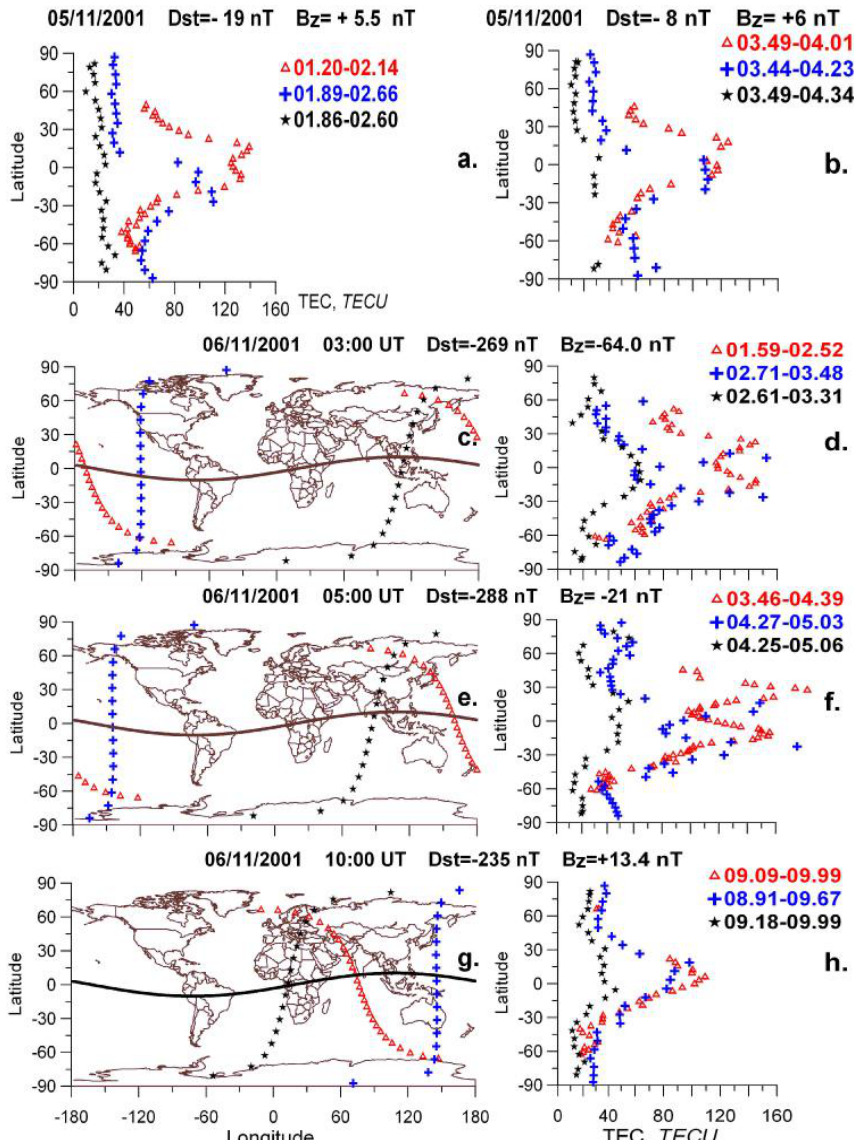
Fig. 2. TEC changes occurred on 5 November 2001 (represent quiet day, panels a , b ) and during geomagnetic storm on 6 November 2001 ( e – h ). TEC measurements were performed by TOPEX (below 1336km, triangles), CHAMP (above 350km, crosses) and SAC-C satellites (above 715km, stars). The trajectories of the satellites are indicated on panels (c) , (e) , (g) , the passes on panels(a) and (b) correspond to the trajectories depicted on panels (c) and (e), respectively. UT of each satellite pass and D st and B z values are written on panels. The satellites pass near the following sectors: TOPEX ∼ 15:00LT, CHAMP ∼ 19:00LT, SAC-C ∼ 10:30LT. Solid line on panels (c), (e), (g) shows position of the geomagnetic